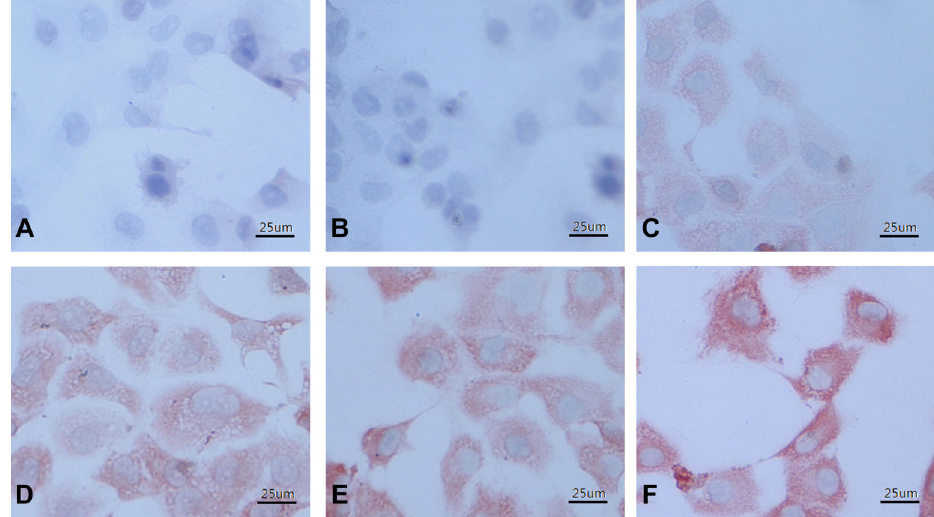
Figure 8. Immunochemical images (400 6 ) of Hsp70 expression in SMMC-7721 hepatoma cells. A , Control group A (RPMI 1640 culture medium only); B , spiking group (8 g/L Fe 2 O 3 , no radiation), after 12 h; C , 2 g/L Fe 2 O 3 MFH group, after 12 h; D , 4 g/L Fe 2 O 3 MFH group, after 12 h; E , 6 g/L Fe 2 O 3 MFH group, after 12 h; F , 8 g/L Fe 2 O 3 MFH group, after 12 h. MFH: magnetic fluid